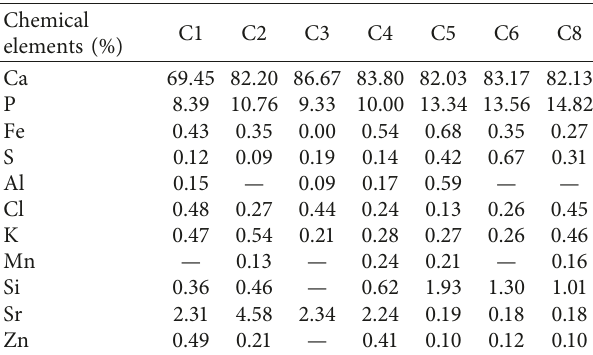
Figure 2: Schematic section showing the stratigraphic distribution of fossils in the GUF’s entrance chamber [9]. Table 1: Chemical elemental percentage of the C1, C2, C3, C4, C5, C6, and C8 samples measured by